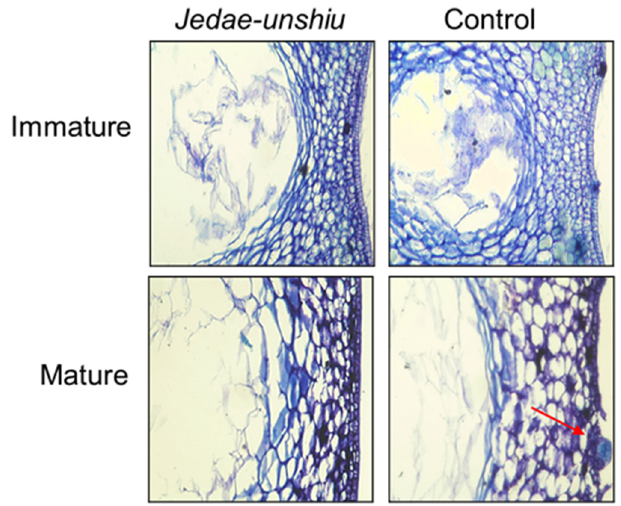
Figure 3. Microscopic observation of immature and mature peels from Jedae-unshiu and control fruits. The red arrow indicates the breakdown of epidermal cells.